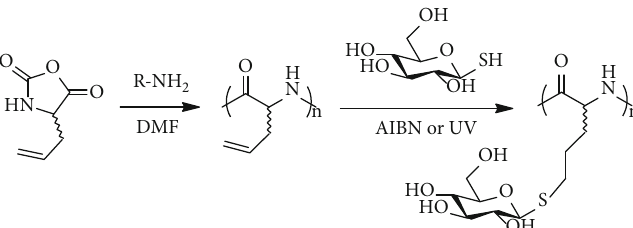
Scheme 3: Ring-opening polymerization of D/L-allyglycine NCA and postglycosylation via thiol-ene “ click ” glycosylation by Sun and Schlaad